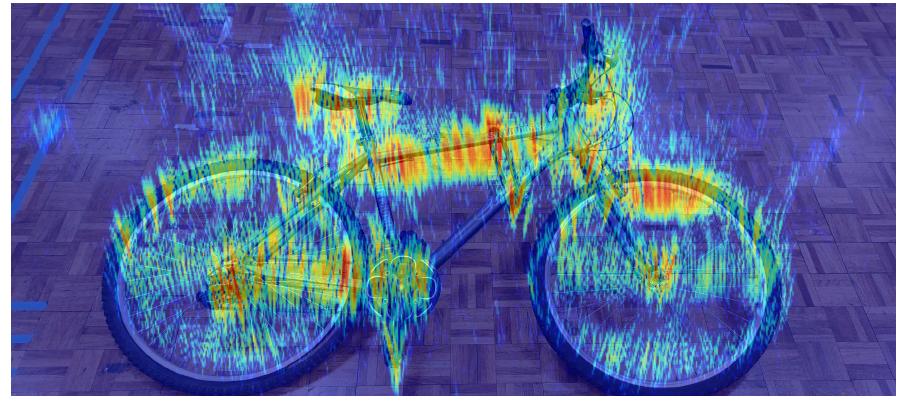
Figure 15. The images of the target bike.